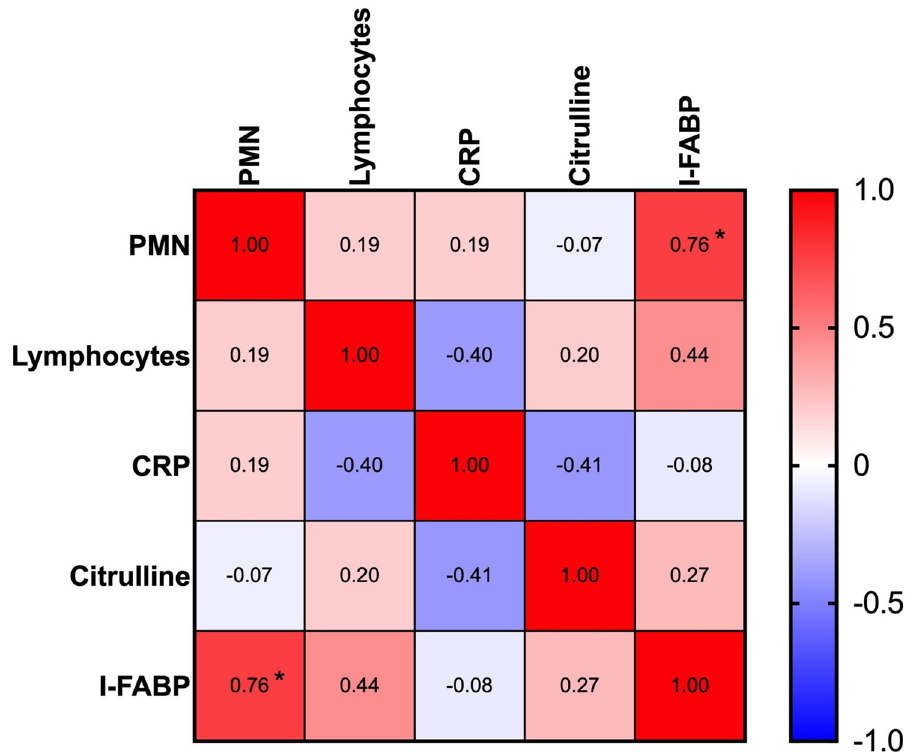
Fig 3. Serum I-FABP correlated with the number of polymorphonuclear cells in COVID-19 patients. Correlation table between serum concentration of I-FABP, citrulline, C reactive protein (CRP), and the number of leukocytes. Pearson correlation test was used. The correlation index is indicated. A negative sign indicates a negative